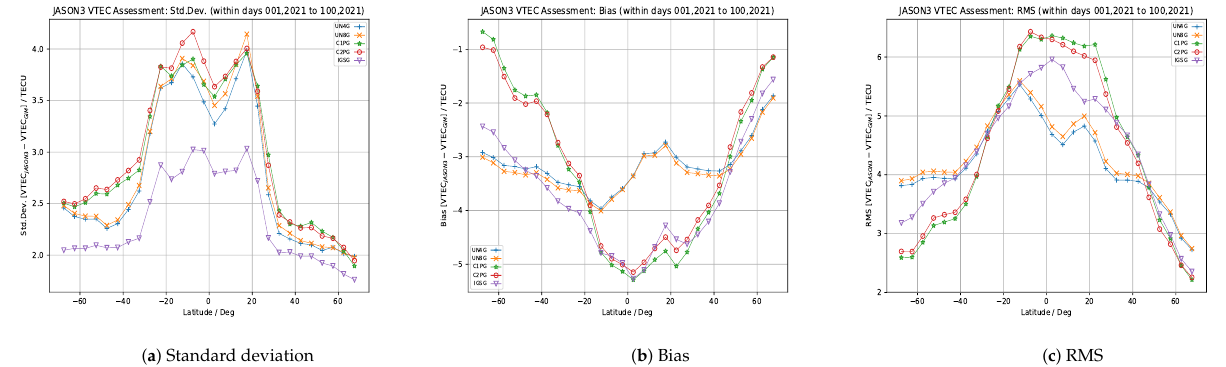
Figure 14. Jason assessment for latitudinal zones, the color representing different products. Note that the measures are weighted by the number of JASON3 observations in cells with the same 5-degree intervals of latitude. Blue: UN4F, Orange: UN8G, Green: C1PG, Red: C2PG, Purple: